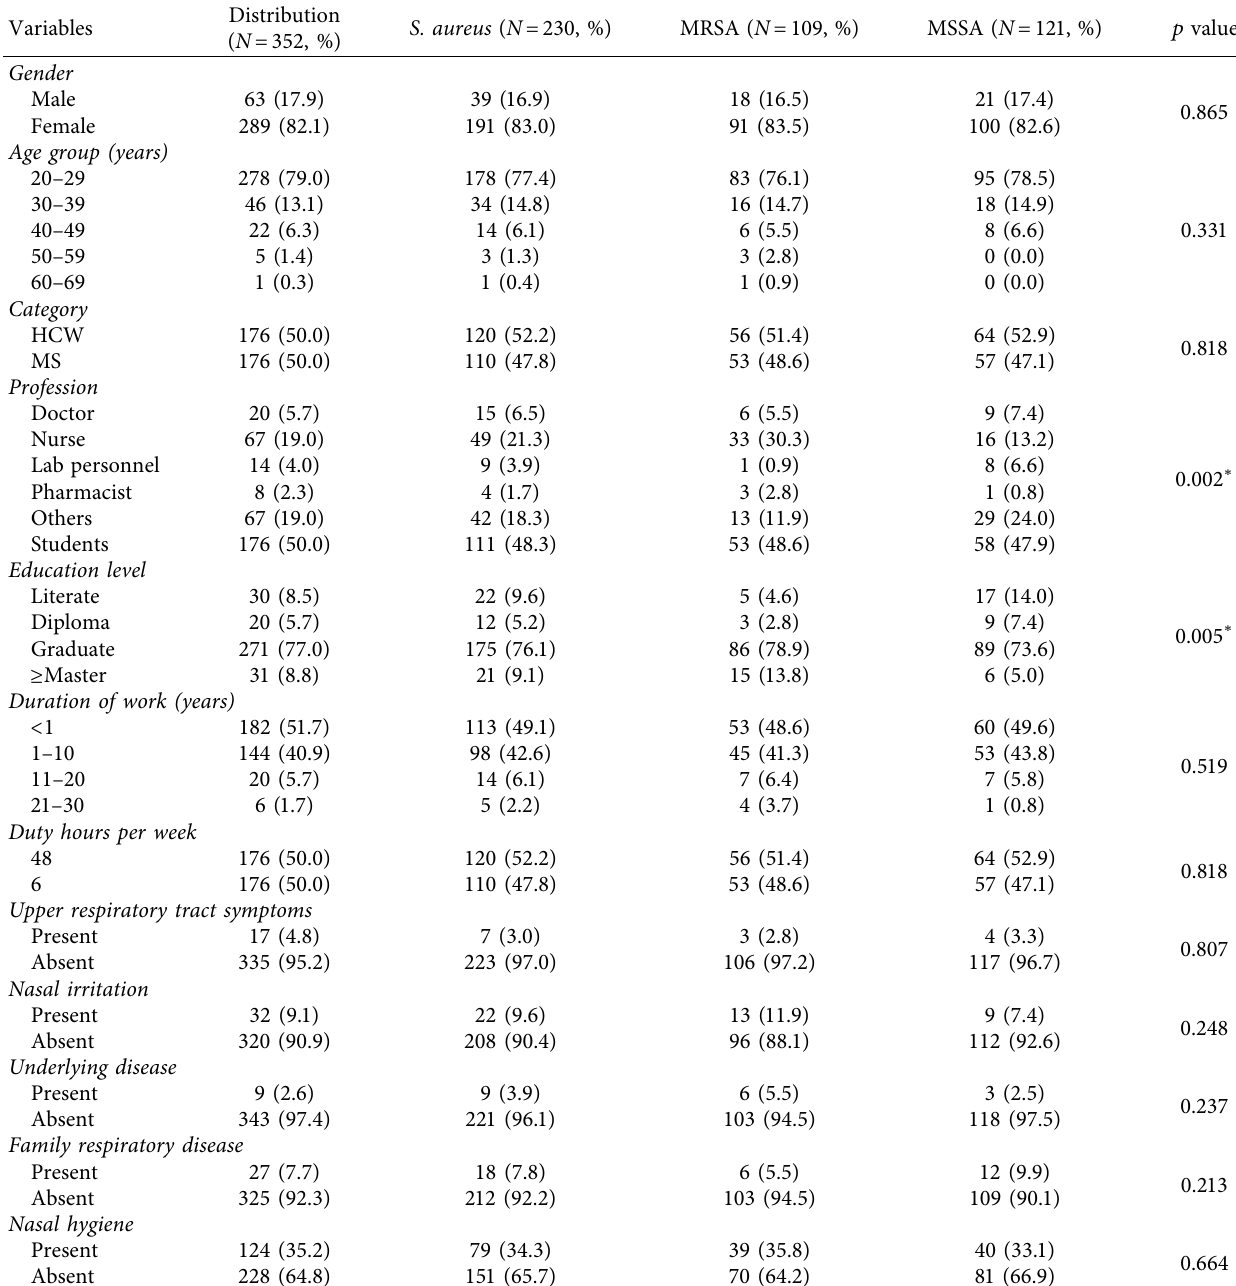
Table 1: Comparison of sociodemographic variables with MRSA and MSSA colonization among